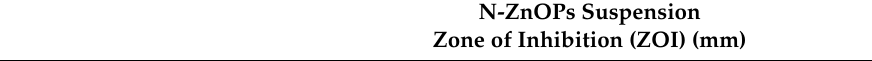
Table 1. Antibacterial activity of N-ZnO Ps.